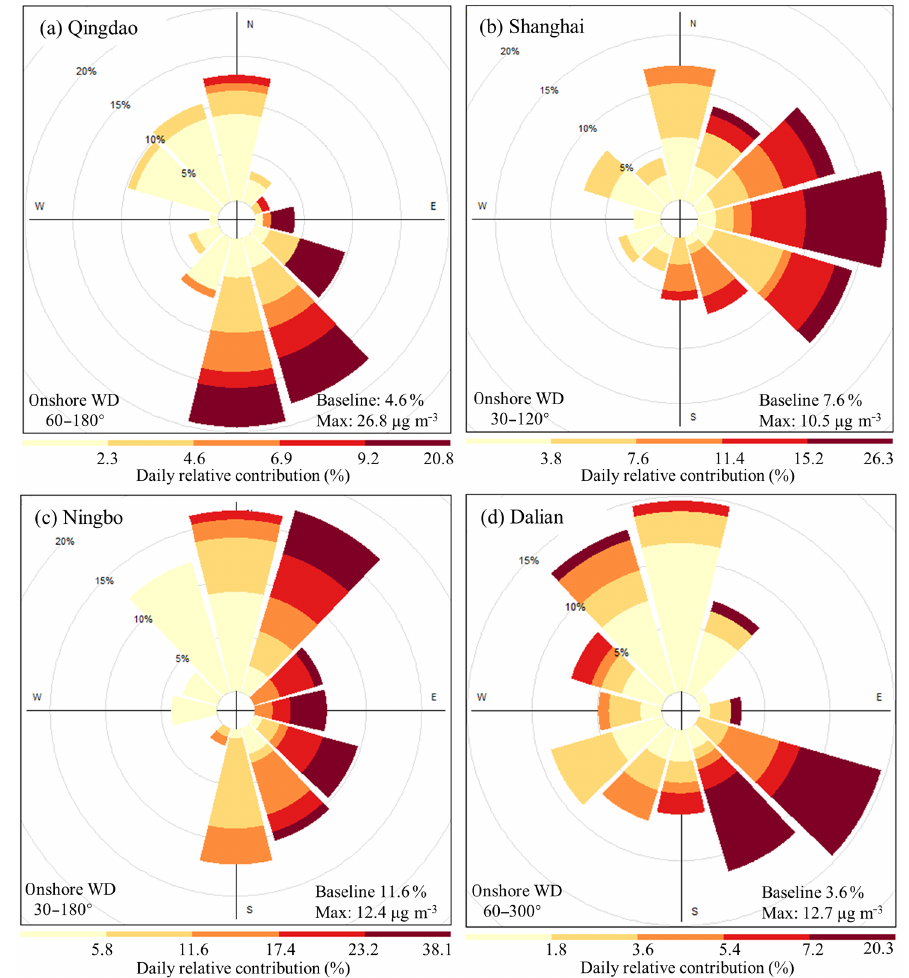
Figure 7. Pollution rose maps in coastal cities: (a) Qingdao, (b) Shanghai, (c) Ningbo and (d) Dalian. The colors represent the daily contributions of shipping emissions to the total PM 2 . 5 concentrations, and the baseline means the annual average of daily contribution. Max is the maximum daily increased PM 2 . 5 concentrations by shipping emissions. The onshore WD is the wind direction in which marine air could be transported over